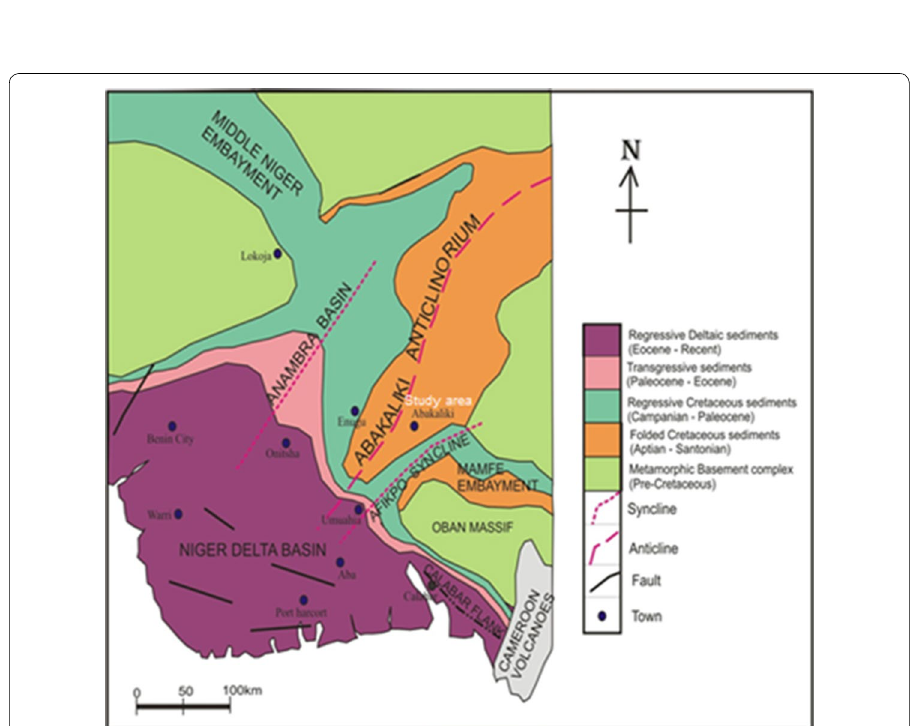
Fig. 6 Tectonic map of southern